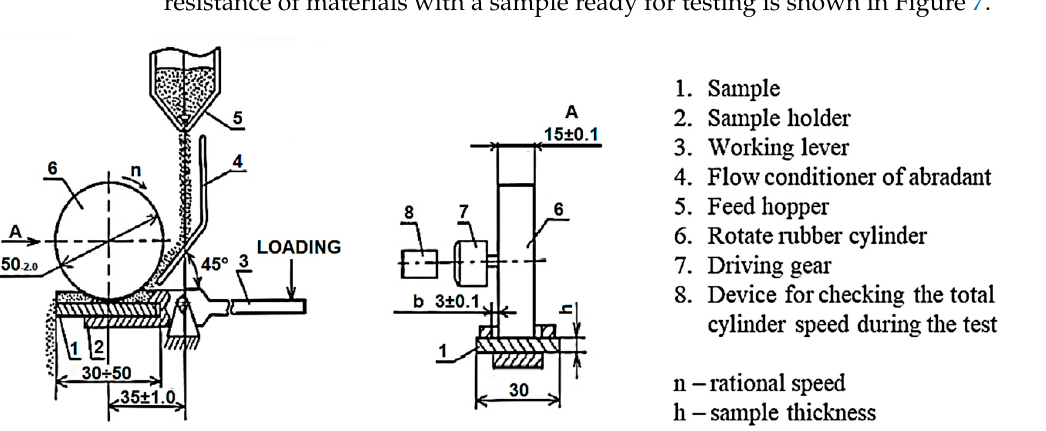
(c) Figure 8. Abrasion resistance and weight measuring equipment (scales); ( a )—scales; (b)—abrasion resistance equipment; ( c )—detail of a driving gear with abrasive particles. Table 4. Parameters of the test equipment. Length of the Friction Path in One Cycle R (m)